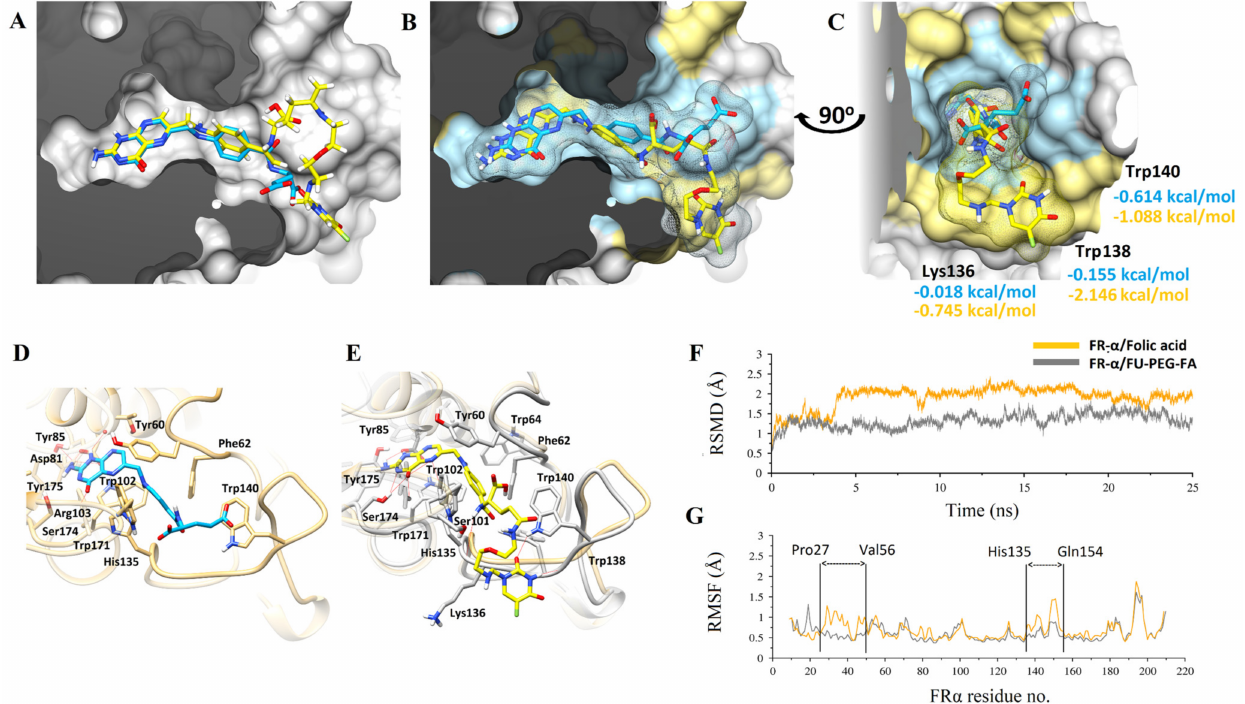
Figure 5. Molecular modeling studies of FA (in blue-grey sticks) and FA-PEG-5-FU (in yellow- orange sticks) in complex with FR α displayed in molecular surface representation. Molecular modeling studies of Folic acid (in blue sticks) and FU-PEG-FA (in yellow sticks) in complex with FR α displayed in molecular surface representation. ( A ), docked complexes with lowest energy ligand conformations are superimposed with surface clipped representation. ( B ) MD simulated stabilized conformations over a period of 25 ns are superimposed while the molecular surface of interacting residues is highlighted in blue (FA) and yellow (FU-PEG-FA), respectively. ( C ) Molecular surface in slab representation covering the deep binding groove is displayed with corresponding ligands in the same color scheme. The highly interacted residues after per-residue decomposition analysis are displayed with theoretical free binding energies. ( D , E ) FR α binding site residues are displayed interactively while the flexible flanking loop is more structured in ( E ). ( F ) Root-mean-square deviations (RMSD) for both complexes are plotted over a period of 25 ns while, ( G ) Root-mean square fluctuations (RMSF) with the flexible loops are pointed